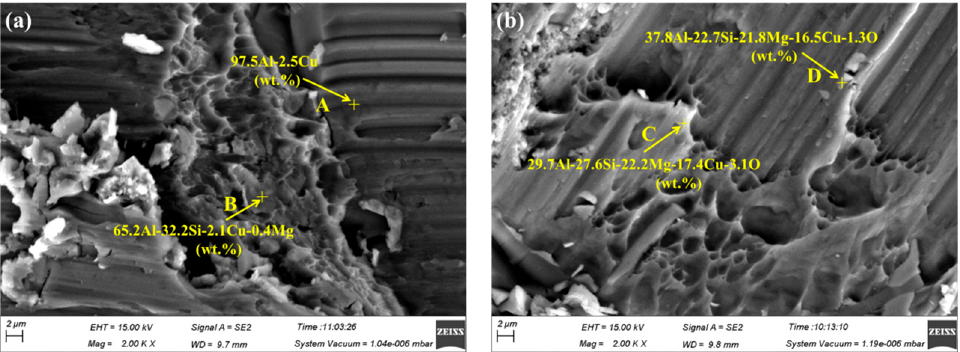
Figure 12. Scanning fracture morphology and EDS analysis of the joint made using micro-nano brazing filler metal Al-17.0Cu-8.0Mg at a temperature of 580 °C and holding time of 30 min: ( a ) one side of the fracture; ( b ) the other side of the fracture.